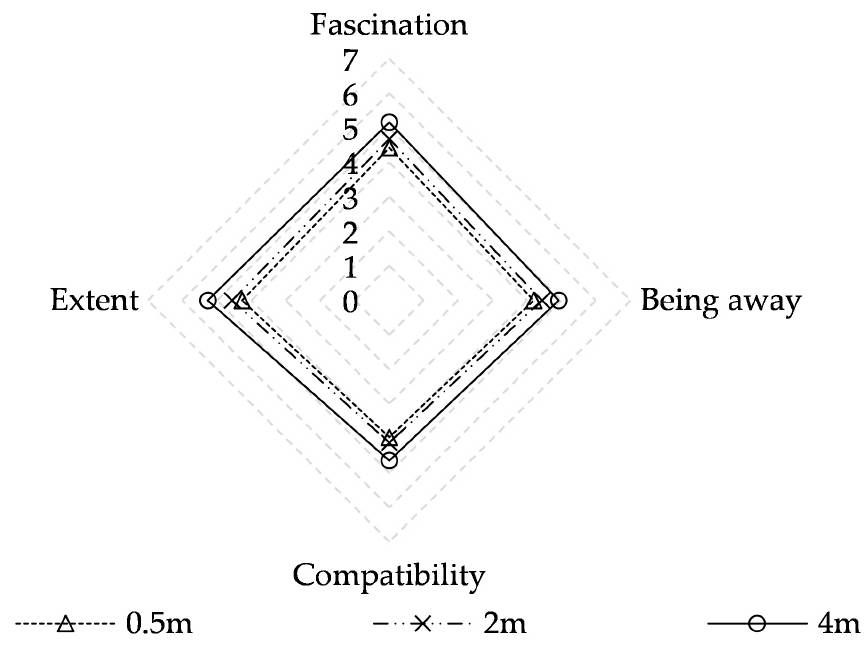
Figure 4. Mean PRSS evaluation scores at different heights. Table 7. Paired samples test results of PRSS and PRSS item evaluations at different heights. Fasc = fascination; Away = being away; Comp = compatibility; and Exte = extent.